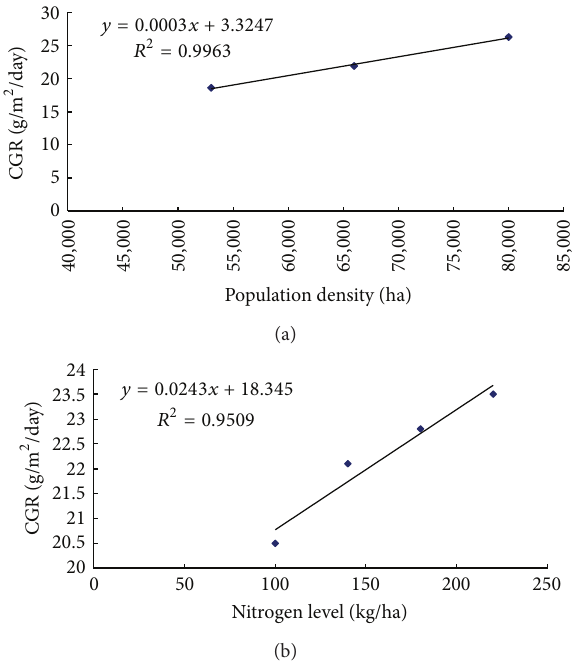
Figure 5: Functional relationship between (a) population density and CGR, (b) nitrogen level and CGR.